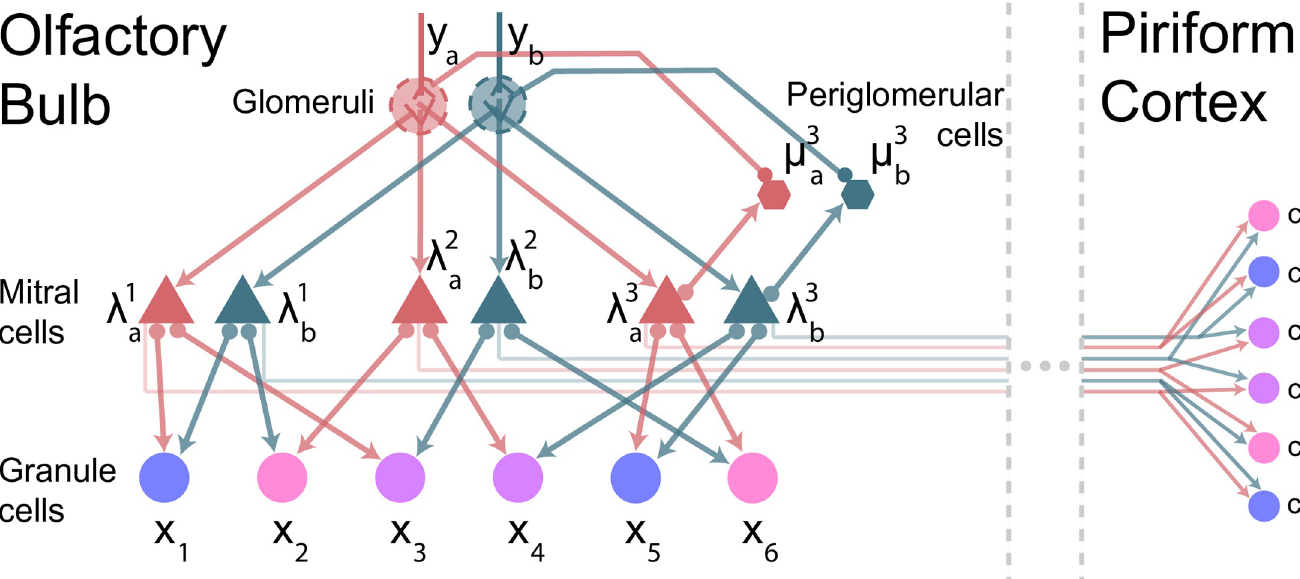
Fig 4. Sparsely connected inference circuit, with readout in piriform cortex. Arrows and filled circles indicate excitatory and inhibitory connections, respectively. Each sister cell l s receives input y from a glomerulus and interacts with a subset of the granule cells x , reducing connectivity by a factor of S ( S = 3 in this example). a j a Information is shared between granule cells through the periglomerular cells m s (only ones with S = 3 are shown, for clarity). Those cells receive excitatory input from a the mitral cells and inhibitory input corresponding to the average sister cell activity (as required by Eq (33b)). The inhibitory input comes from back-propagating action potentials, which travel along mitral cell apical dendrites and are available at the glomeruli [24, 25]. The result of the inference is simultaneously available in granule cells and neurons in piriform cortex (see Methods, Sec. 4.5, ‘Cortical readout’).